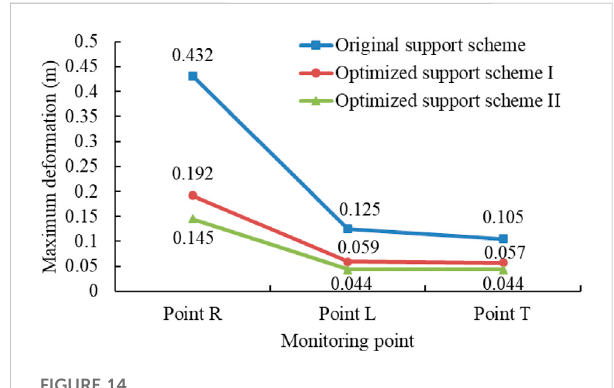
FIGURE 14 Comparison of maximum deformation at different points under various support schemes.